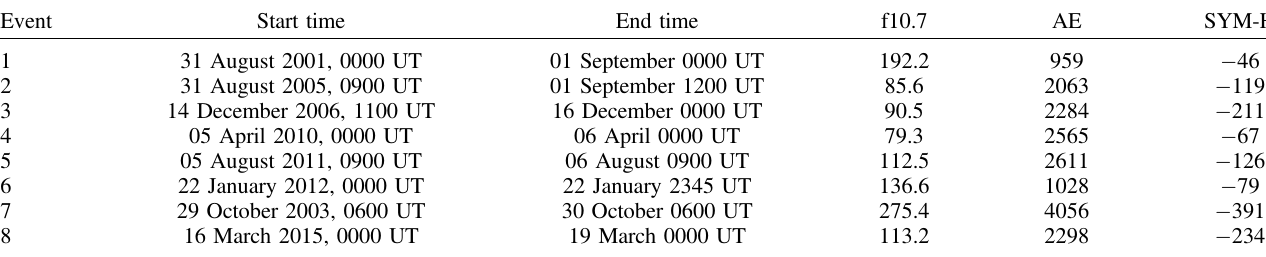
Table 1. List of events.